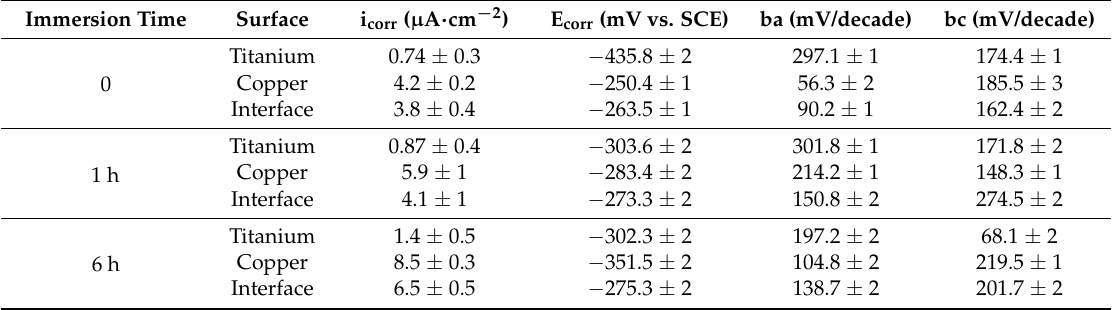
Table 2. Potentiodynamic polarization parameters for Ti, Cu and weld interface electrodes in 3.5% NaCl at different immersion times.